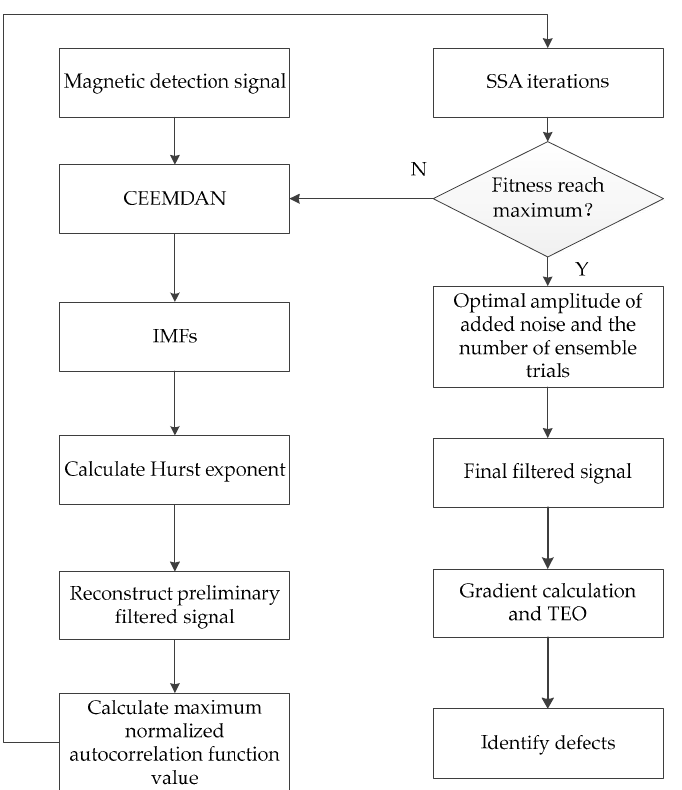
Figure 3. A flowchart of the proposed method.